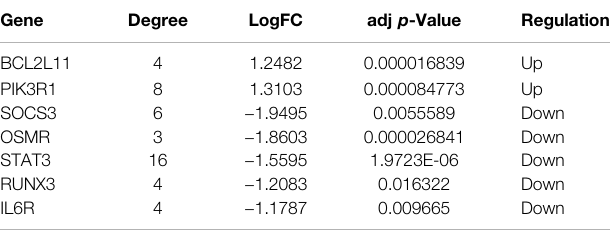
TABLE 2 | Hub genes identi fi ed from the PPI network